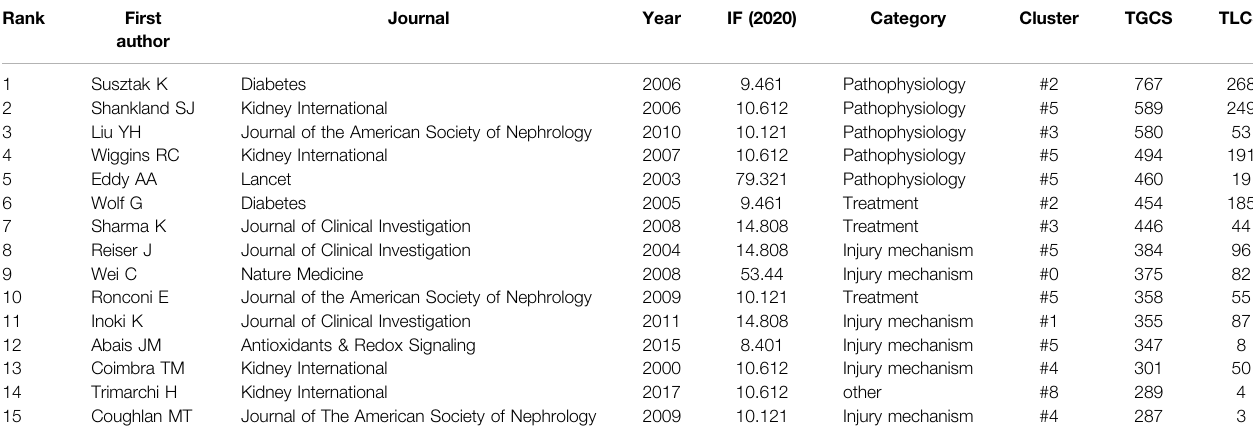
TABLE 5 | The top 10 literatures with the highest number of citations.